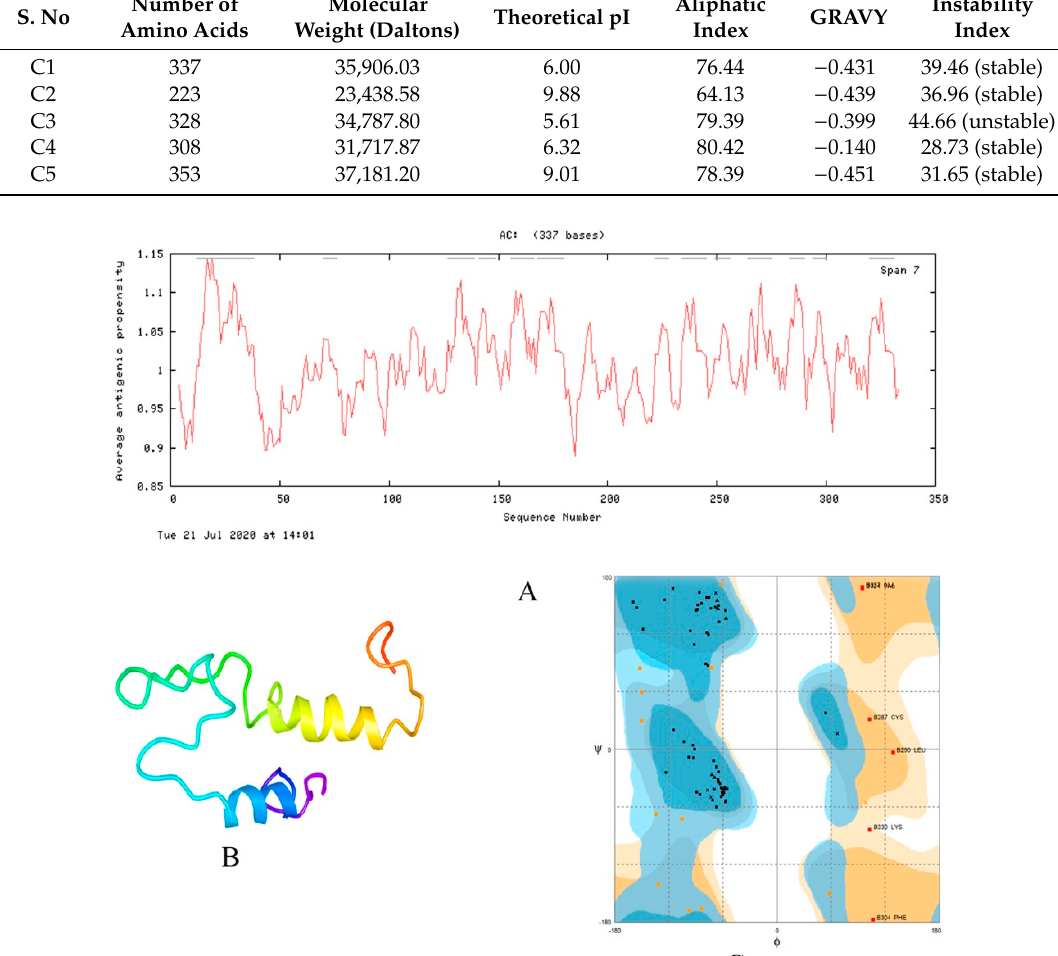
Table 4. Physiochemical properties of the vaccine constructs.